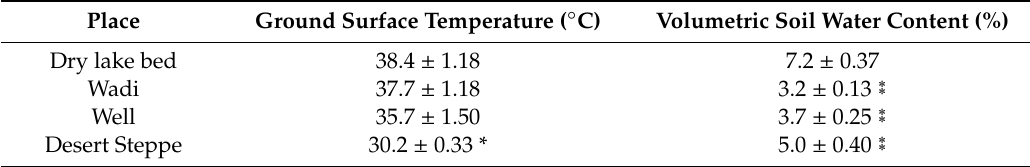
Table 1. Ground surface temperature and volumetric water content in Gobi Desert.